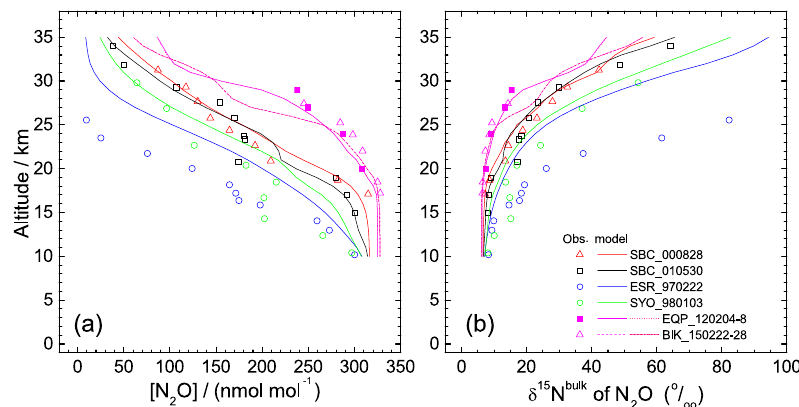
Figure 8. Comparison of vertical profiles of mixing ratio (a) and δ 15 N bulk (b) of N 2 O between observations and simulation by the ACTM. Model simulations for equatorial profiles were conducted for two dates because the observations were conducted during a 5- or 7-day period.